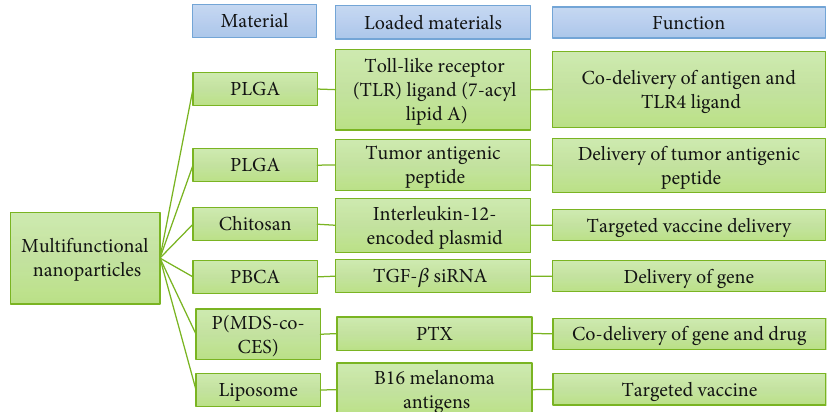
Figure 4: Representative examples of multifunctional nanoparticulate systems studied in vivo for cancer immunotherapy [43 – 50]: PLGA- Poly(lactide-o-glycolic acid), PBCA-Polybutyl cyanoacrylate, and P(MDS-co-CES)-A triblock